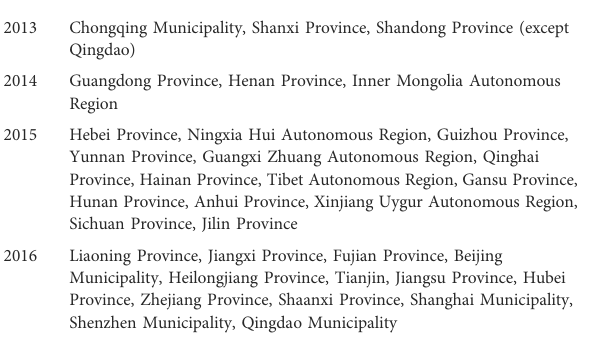
TABLE 1 Implementation of “ Golden Tax III ” in Chinese provinces and municipalities.